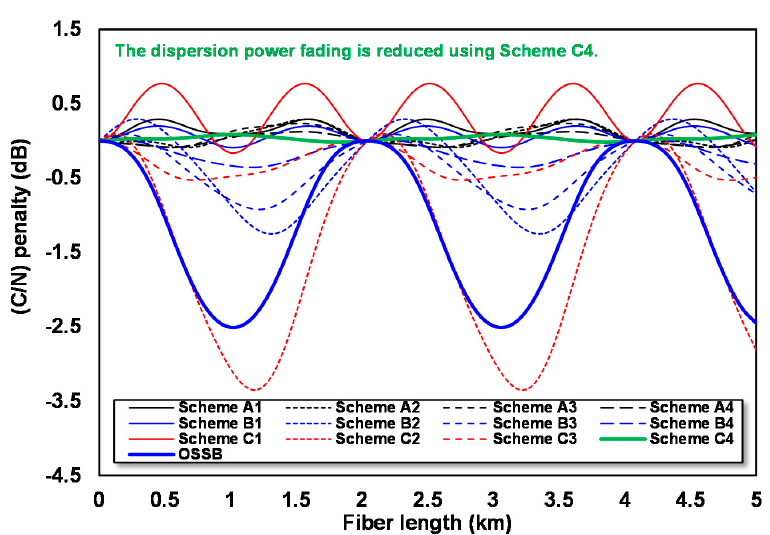
/ N penalty with an irregular θ for all schemes at modulation index m = Figure 12. RoF links the C/N penalty with an irregular θ for all schemes at modulation index m = 1. Figure 12. RoF links the C